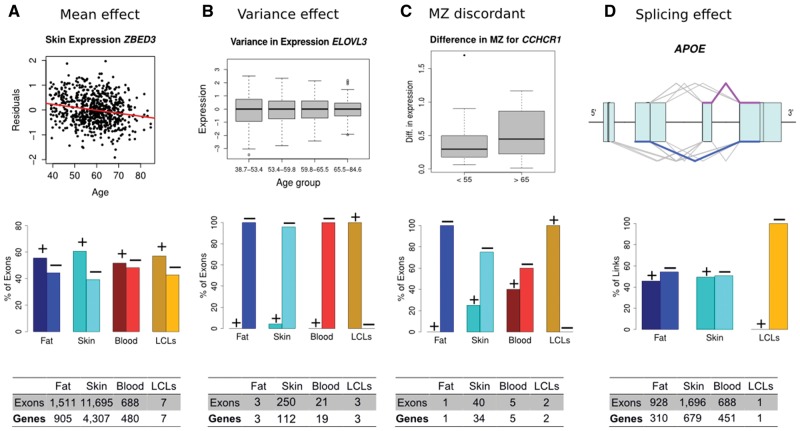
Effects of aging in gene expression: The effect of aging in gene expression is not limited to changes in mean expression values with age (A), but includes also changes in levels of phenotypic variance (B, C), and splicing (D). The top row graphs show real data examples for the effects of aging in expression investigated. The middle graphs show bar plots with the percentage of exons with positive (+) or negative (−) age effects in each analysis. And finally, the bottom tables provide the number of exons and genes with significant association for each of the effects presented. All the real examples are from skin, the tissue with larger age effect in expression overall analyses. (A) Effect of aging in mean gene expression, usually referred as differentially expression with age in exons. The example shows the residuals (after removing technical covariates) of the expression of the ZBED3 gene decreasing with age. Skin is the tissues with a larger effect of age in expression and LCLs the smaller. (B) The effect of aging in variance of gene expression is shown with the ELOVL3 gene and a significant decrease of variance in expression with age. From the bar plot it is possible to appreciate that the majority of the significant exons had a decrease in variance with age. (C) Differences in expression between monozygous (MZ) twins point out to environmental factors different among the siblings affecting gene expression, since MZ twins are genetically identical individuals with the same age. The example shows the difference in expression between MZ twins in the gene CCHR1. (D) For the splicing analysis, only links (reads between two exons) were considered. The example shows the structure of the gene APOE with its exons (boxes) and lines connecting the exons representing reads spanning between two exons. The number of reads linking exons 3 and 4 (in purple) decreased in number with age, while reads linking exons 2 and 4 (blue) increased with age (Fig. 5 for details). The model suggested that an isoform skipping the third exon (from the 5') may be more abundant in older individuals compare to an isoform that includes the third exon linked to the last exon.